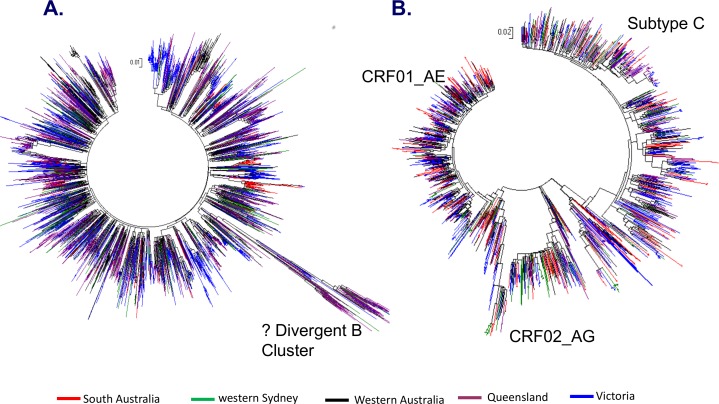
The phylogenetic tree constructions based on HIV-1 pol sequences for (A) HIV-1 B and (B) non-B subtypes assessed in the AMEN study. Each branch colour represents a state (Western Australia (black), South Australia (red), Victoria (blue), western Sydney (green) and Queensland (maroon).